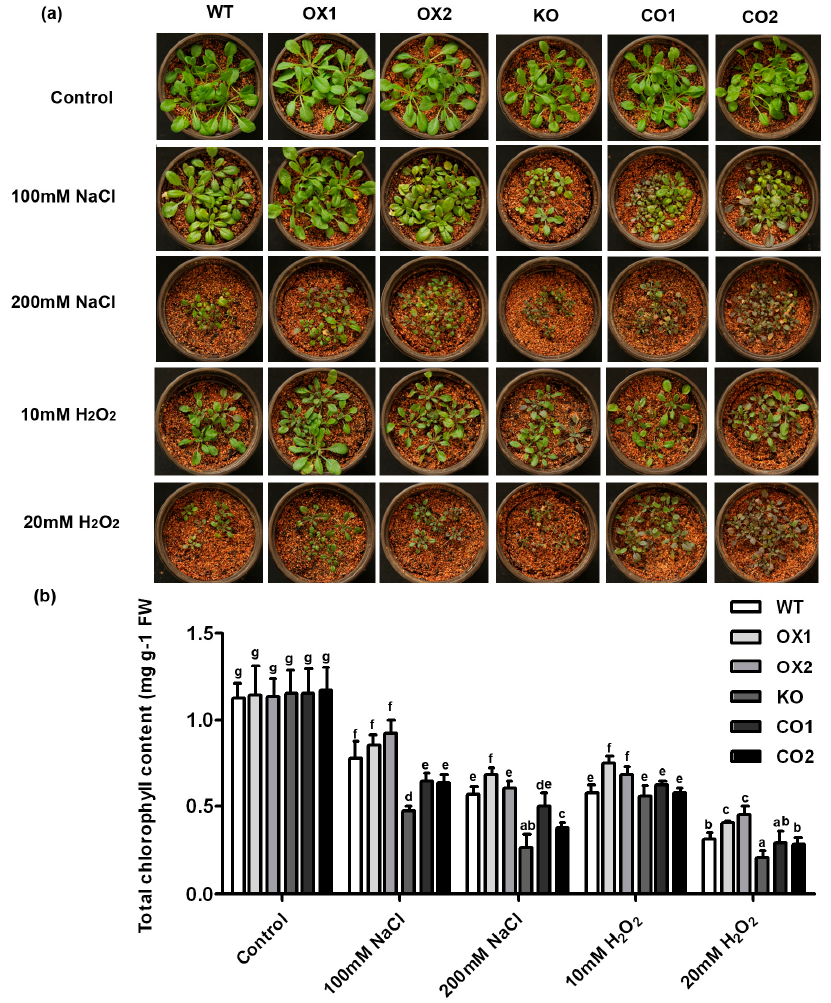
Figure 5. Analysis of salt and H 2 O 2 tolerance in transgenic Arabidopsis plants in comparison with the wild type and atsams3 mutant in soil. ( a ) Phenotypes of wild type (WT), BvM14-SAMS2 -overexpressed seedlings in wild type Arabidopsis (OX), atsams3 mutant (KO), and BvM14-SAMS2 in mutant complementation seedlings (CO) under conditions of control and stress in soil. Photographs were taken 7 days after treatment; Total chlorophyll levels ( b ) were determined. Data are the means of three biological replicates (SD) and each replicate contains five seedlings. Different letters indicate significant difference at p < 0.05.